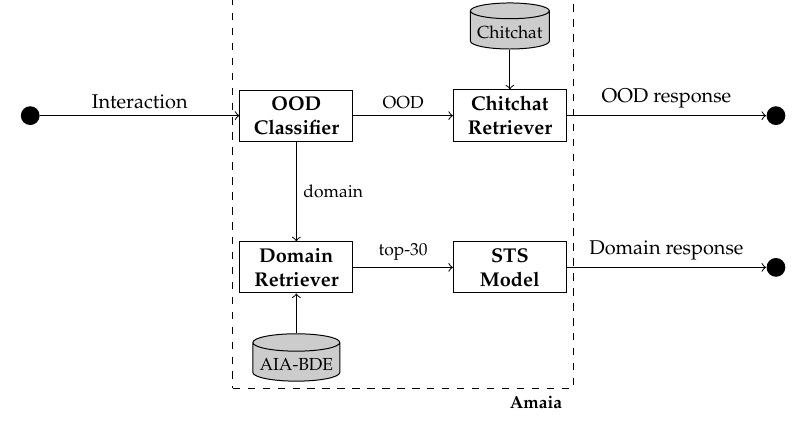
Figure 1. Amaia’s